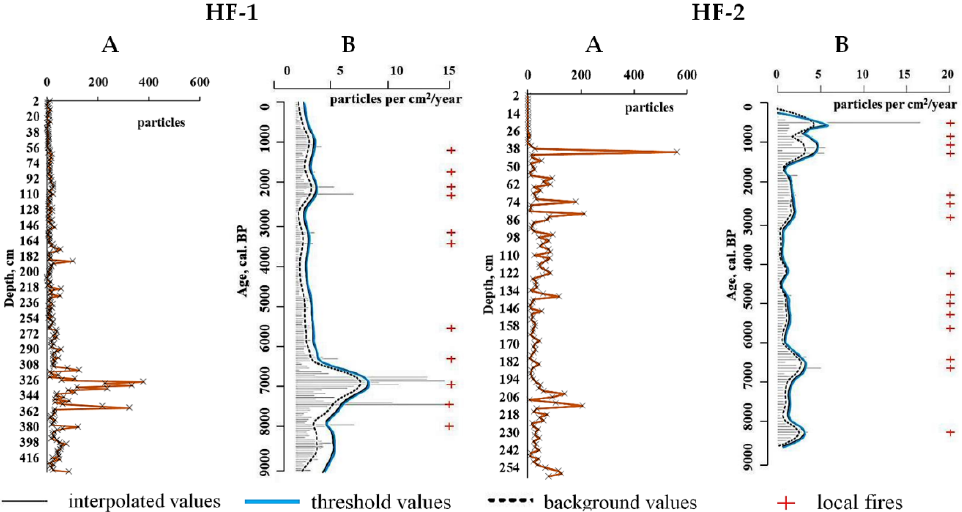
Figure 3. The amount and rate of accumulation of charcoals in the studied peat. ( A ) is the amount of coals in the soil profile (particle) and ( B ) is the model of the rate of coal accumulation (particles per cm 3 /year).